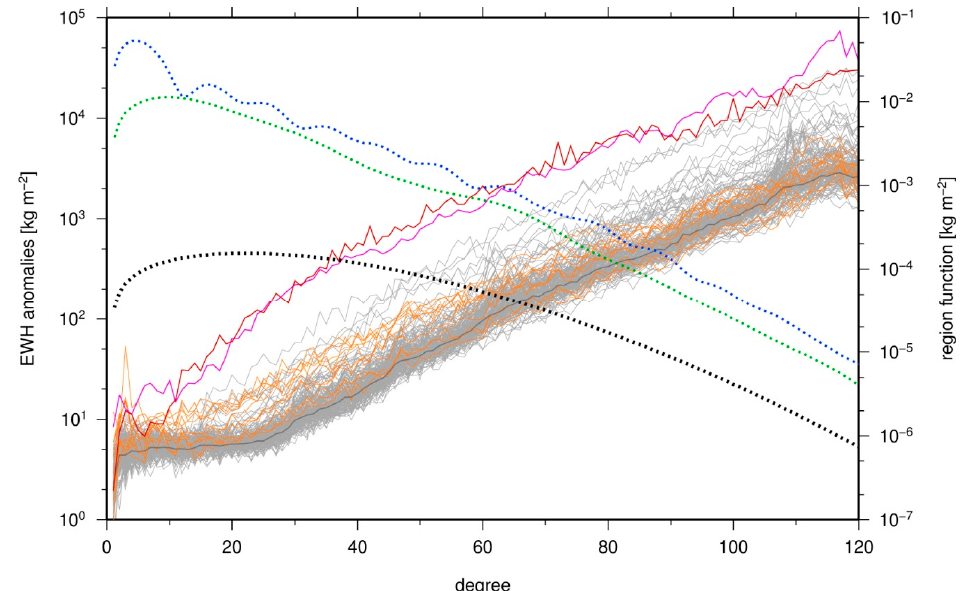
Figure A1. Degree amplitudes of equivalent water height anomalies for all of the solutions of the GRACE Level-2 data period (left axis). Light grey: monthly solutions from April 2002 through March 2016; orange: from April 2016 through June 2017; red: February 2015 (two-day repeat orbit); magenta: March 2017; dark grey: median among all monthly solutions. Dashed curves show degree amplitudes for filtered region functions (right axis) for SPI and NPI (black); AIS (blue) and Greenland ice sheet